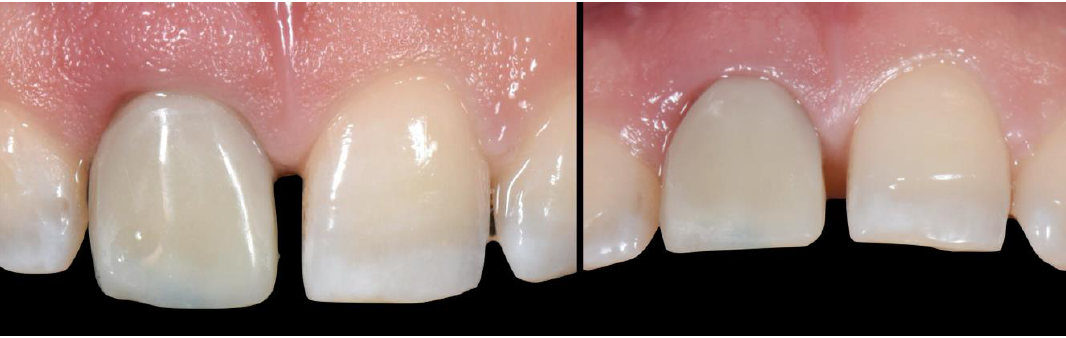
Figure 16. Facial view of the transitional restoration after cementation.